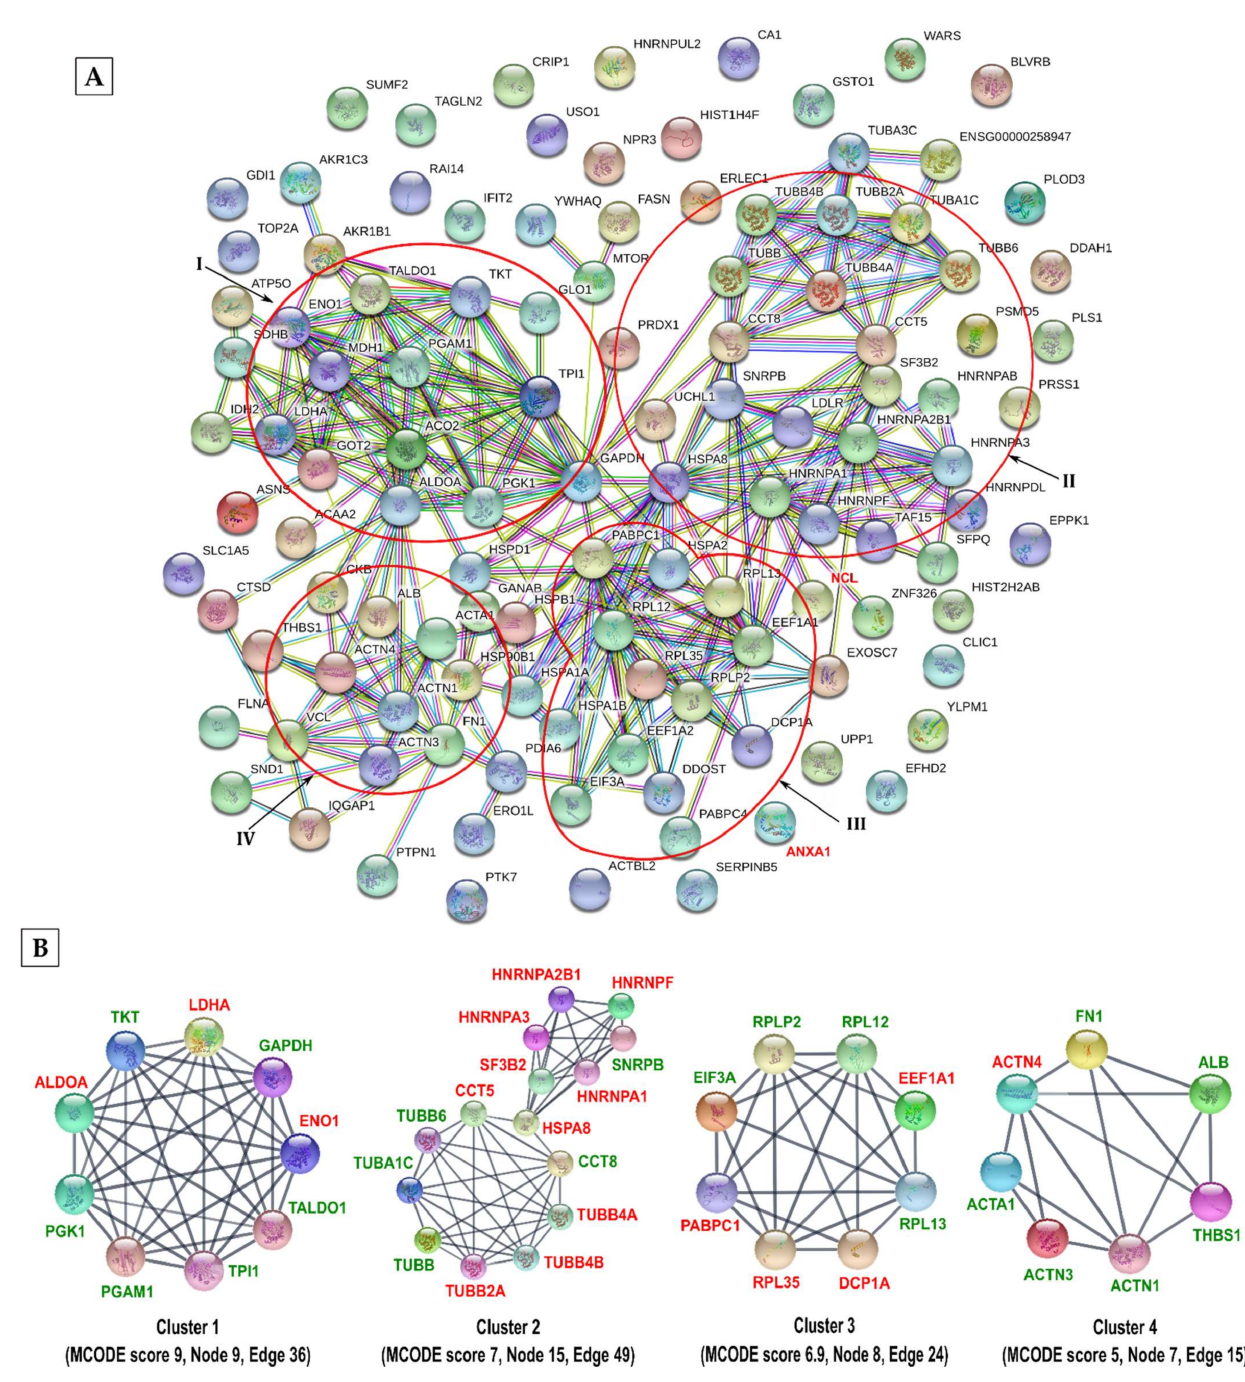
Figure 6. STRING functional protein association network of identified methylated host proteins. ( A ) The identified methylated host proteins from infected cells were analysed for functional protein associations using the STRING database. The network contains 336 edges and 102 nodes with an average node degree of 6.59. The minimum required interaction score was set to high confidence ( ≥ 0.700) and PPI enrichment p -value was <1.0 × 10 − 16 . Major clusters are encircled in red. ( B ) The four most highly ranked and tightly connected methylated protein clusters were obtained by the MCODE algorithm using Cytoscape (version 3.8.0) and ranked based on their MCODE scores. The proteins shown in red are known to be involved in influenza virus